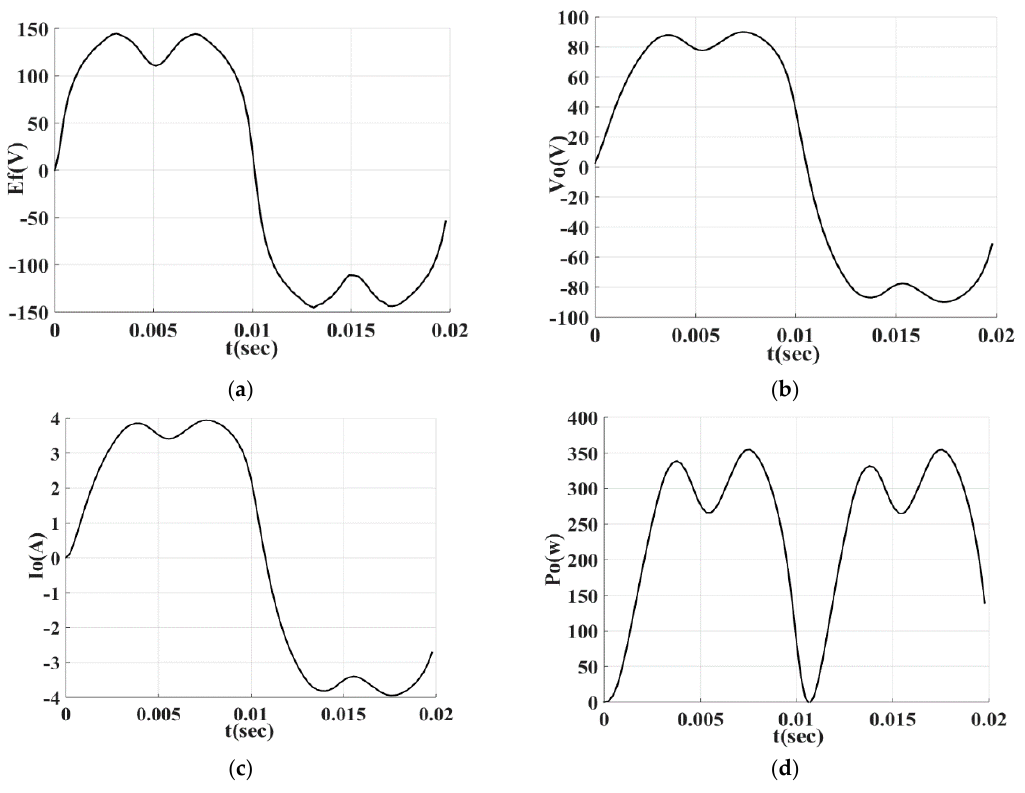
Figure 14. Finite element results: ( a ) no load voltage; ( b ) full load voltage; ( c ) full load current; ( d ) output power in full load.